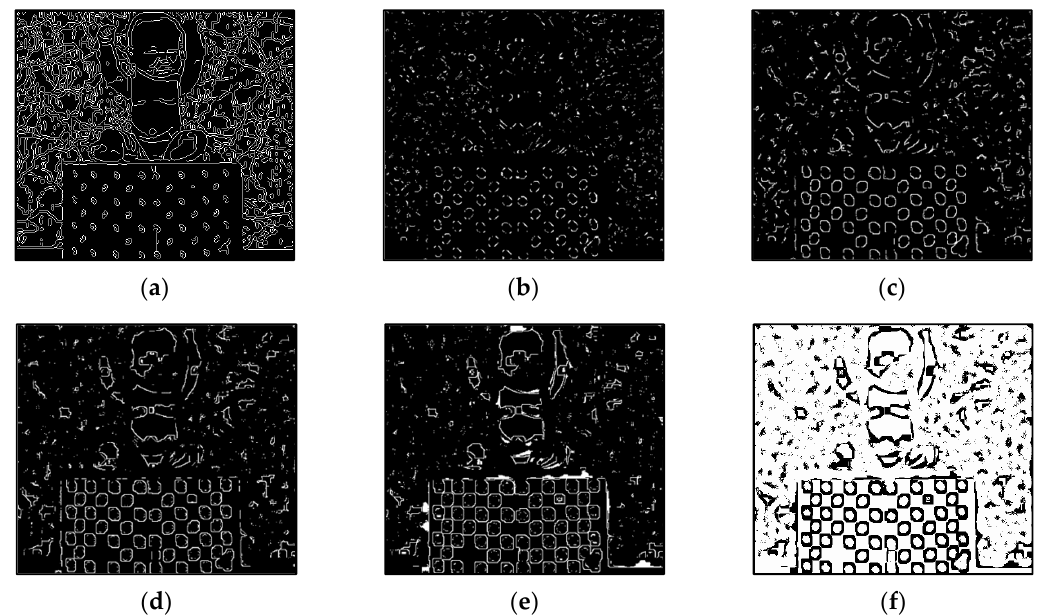
biggest window size in ( b ) 13 × 13, ( c ) 15 × 15, ( d ) 17 × 17, ( e ) 19 × 19, and ( f ) 21 × 21.